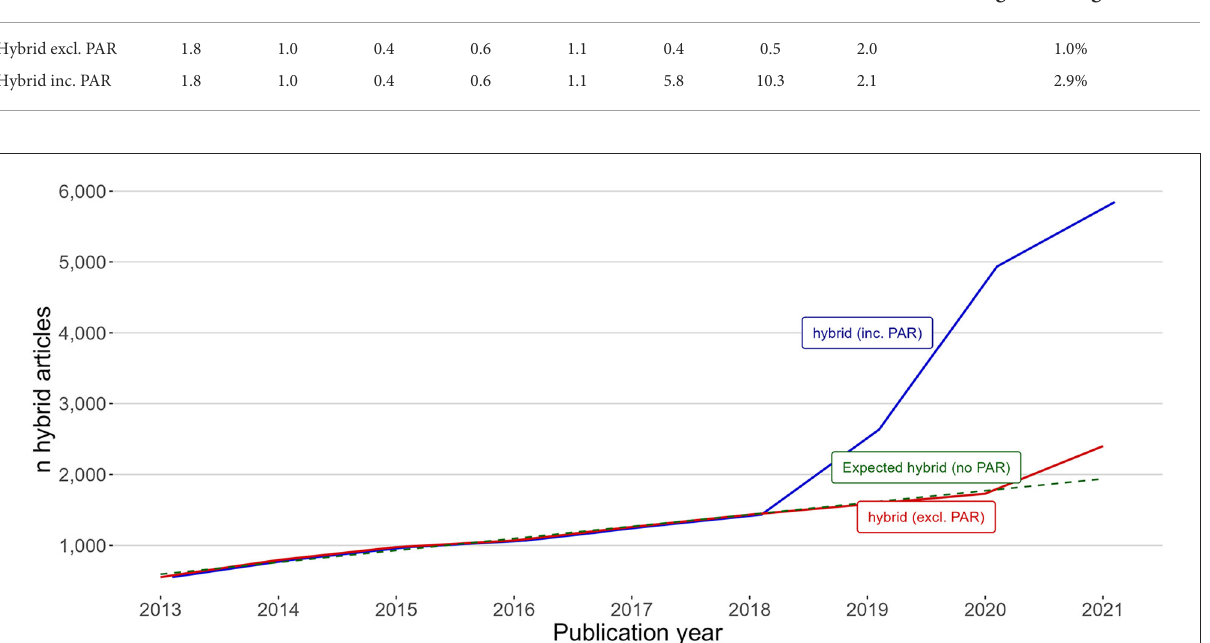
TABLE 2 Annual growth rate of hybrid open access articles calculated from the previous year, starting in 2013. 2014 2021 Average annual growth rate